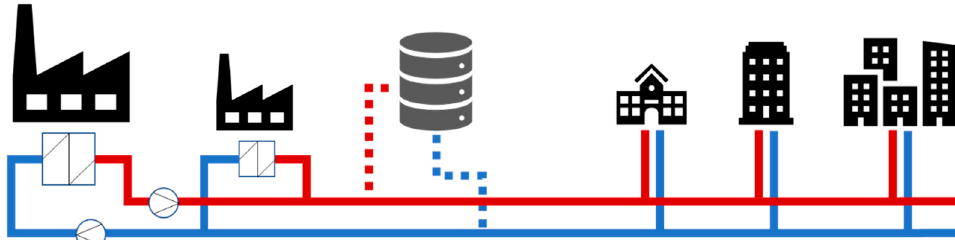
Figure 1. District heating (DH) system’s component scheme. From left to right: biomass-fired combined heat and power (CHP), oil-fired heat only boiler (HOB), hot water tank (HWT) and different building types. The HWT’s coupling is marked with dashed lines as it is only utilized in HWT cases.